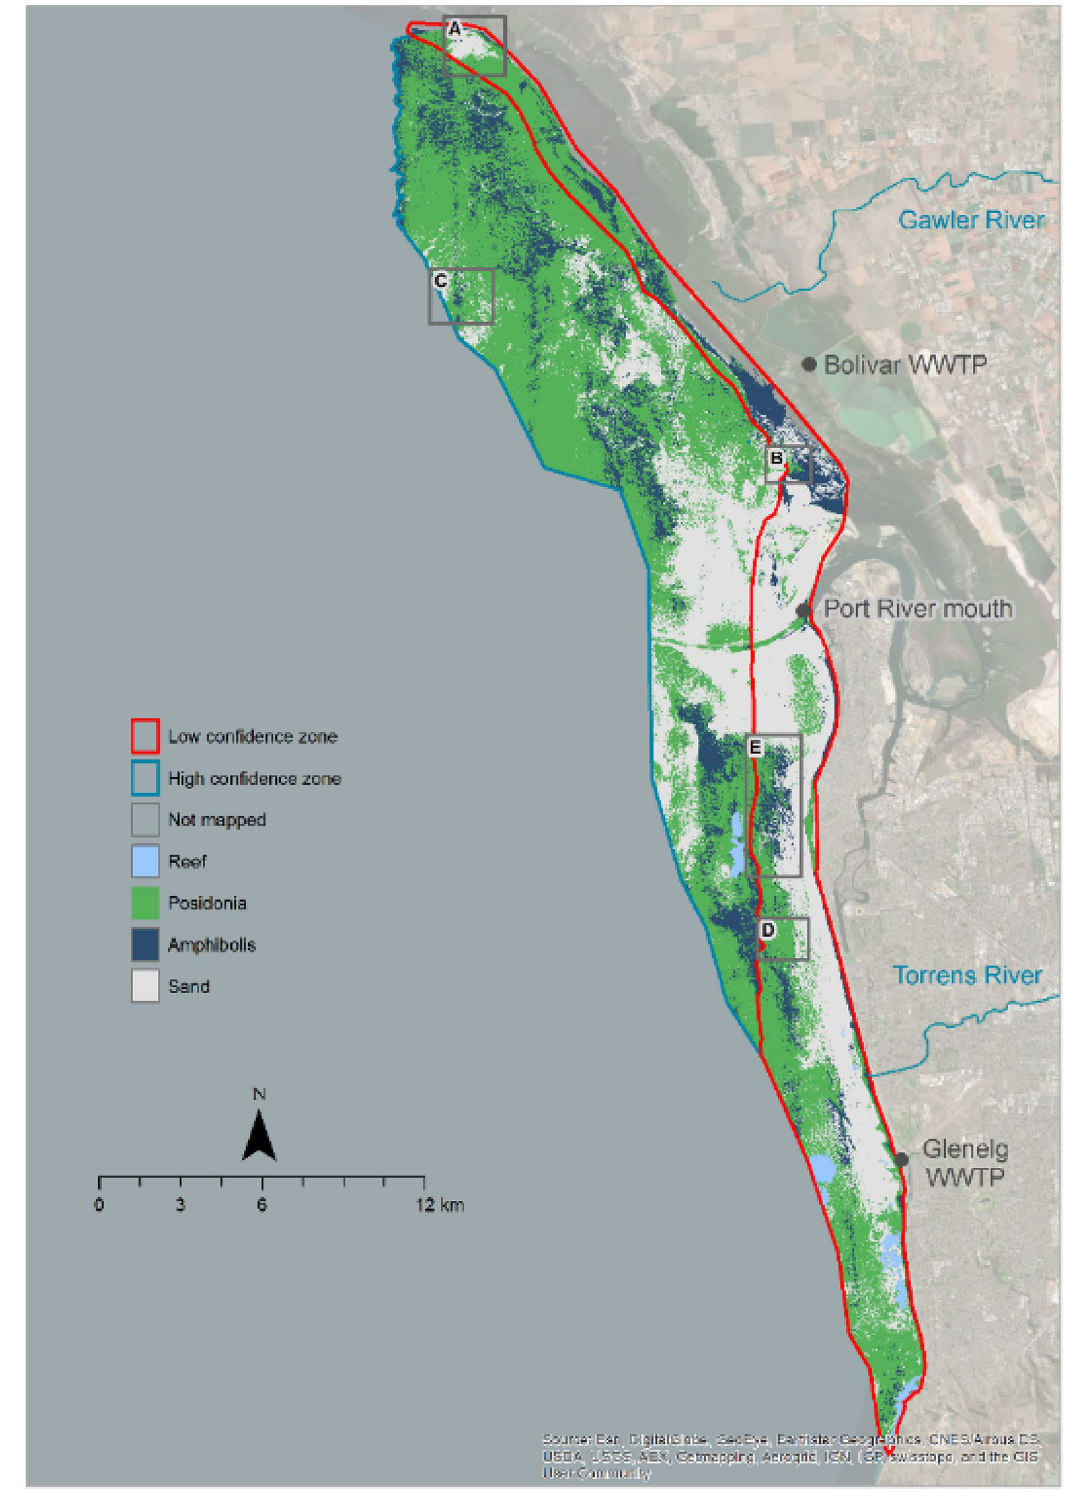
Figure 3. Seagrass genus classification in 2018, with annotations A–E highlighting areas discussed in the text. Map created in ESRI ArcGIS 10.7; terrestrial ESRI Basemap World Imagery (https:// www. esri. com/ en- us/ arcgis/ produ cts/ arcgis- enter